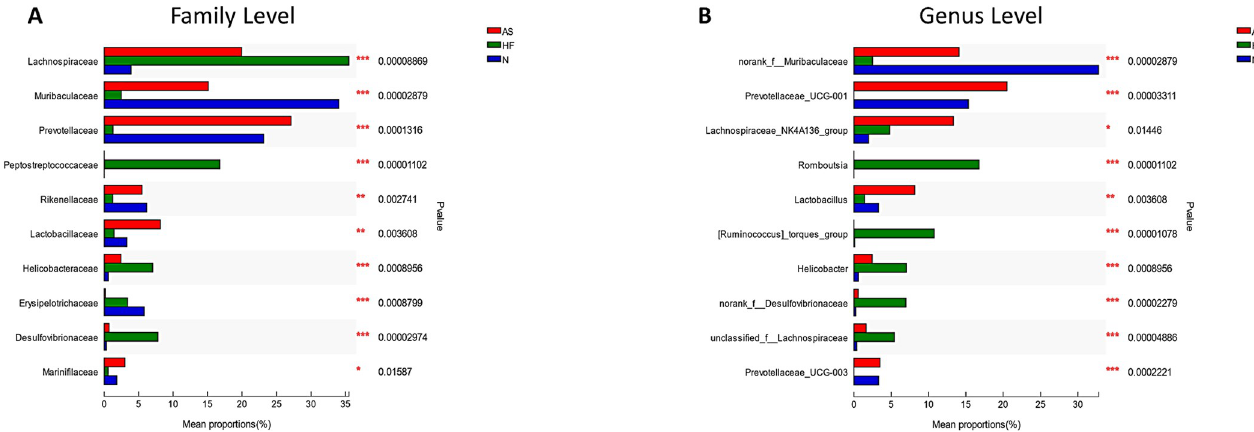
Fig 3. Significantly different species analysis on the family level and genus level. A: Analysis of significantly different species at the family level; B: Analysis of significantly different species at the genus level ( � , P < 0.05; �� , P < 0 .01; ��� , P < 0 .001).